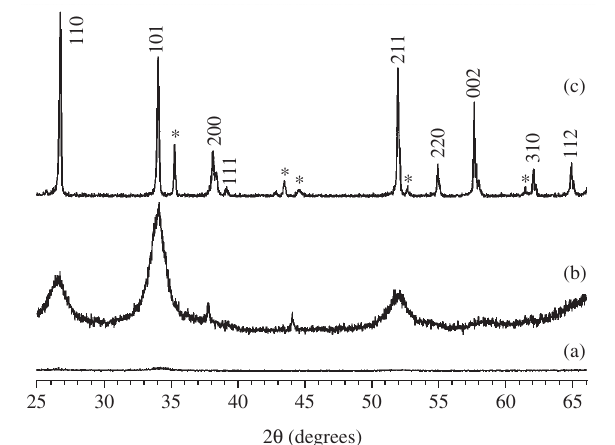
Figure 2. X ray diffraction patterns of films obtained by: a) sputtering, as deposited; b) sputtering, after heat treatment and c) doctor blade. The peaks marked with an asterisk are from the